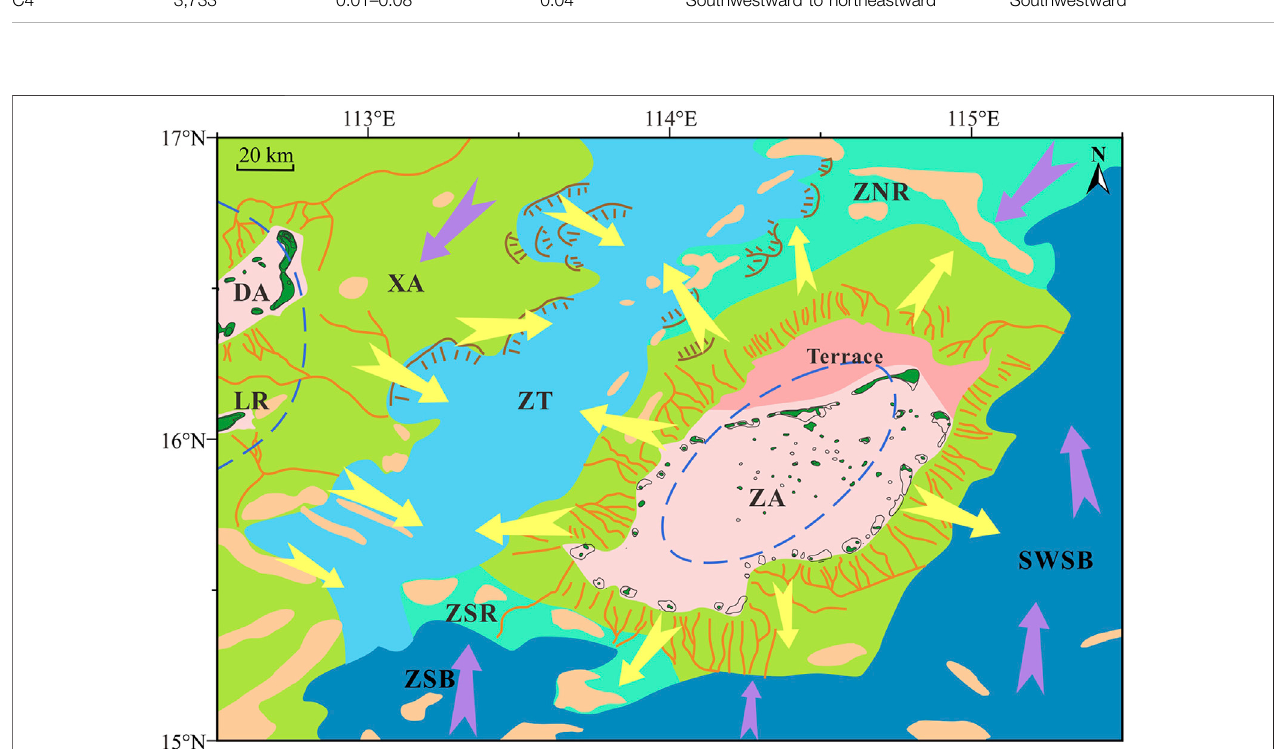
FIGURE 9 | Sediment transport pattern in the study area. Blue circles indicate the sources of gravity fl ows. Yellow and purple arrows represent the sediment transport trends driven by gravity fl ows and bottom currents, respectively. Orange lines indicate the submarine canyons. Brown lines mark the traces of submarine